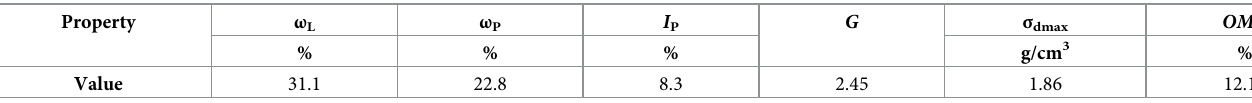
Table 1. Physical indexes of soil used for